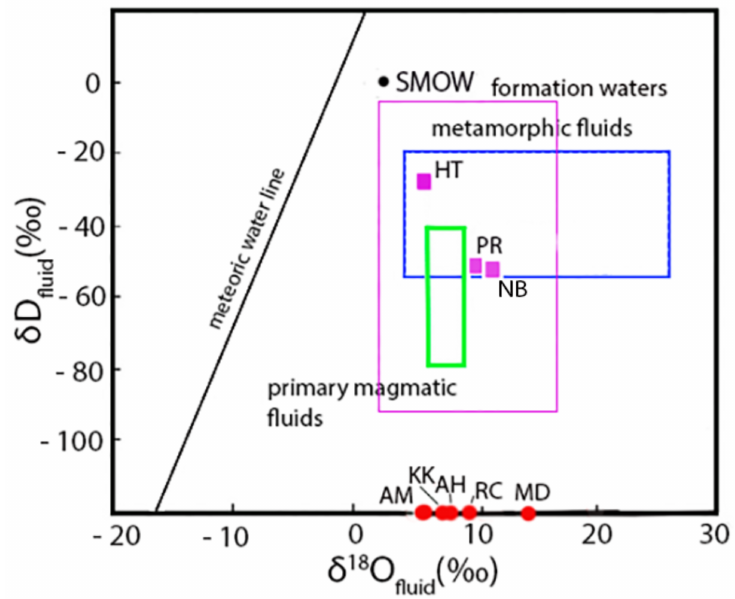
Figure 5. Plot of δ D versus δ 18 O fluid data compared to fluids of different origin. Modified from [68]. (HT-Hutti; PR-Pilgrim’s Rest; NB-Navachab, AM-Awak Mas; KK-Kochkar; AH-Ajjanahalli; RC-Renco;